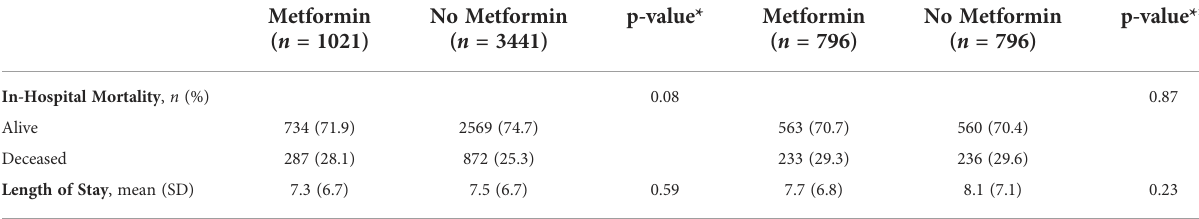
TABLE 2 COVID-19 Clinical outcomes and metformin